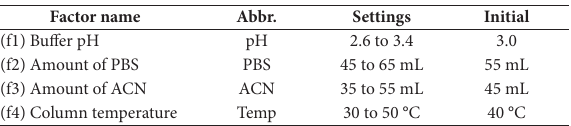
Table 2. Factors and corresponding levels for 2 4–1 fractional fac- torial design used for screening analysis.